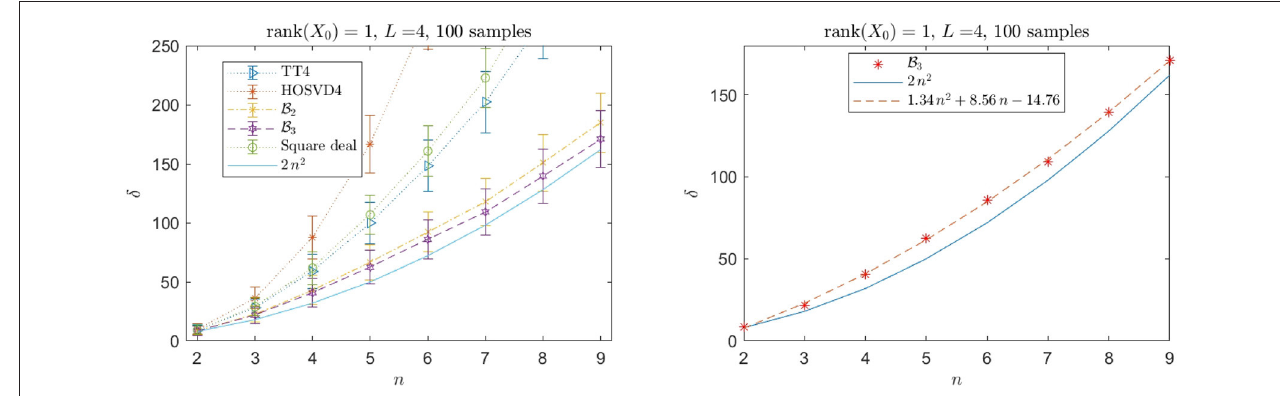
( C n ) ⊗ k with L 4 and the max-norm (97) as regularizer. The norm is given by ∈ = ( 1,2 , 1,3 , 1,4 ), and ( 1,2 , 1,3 ), B 3 : = { } { } { } = { } { }